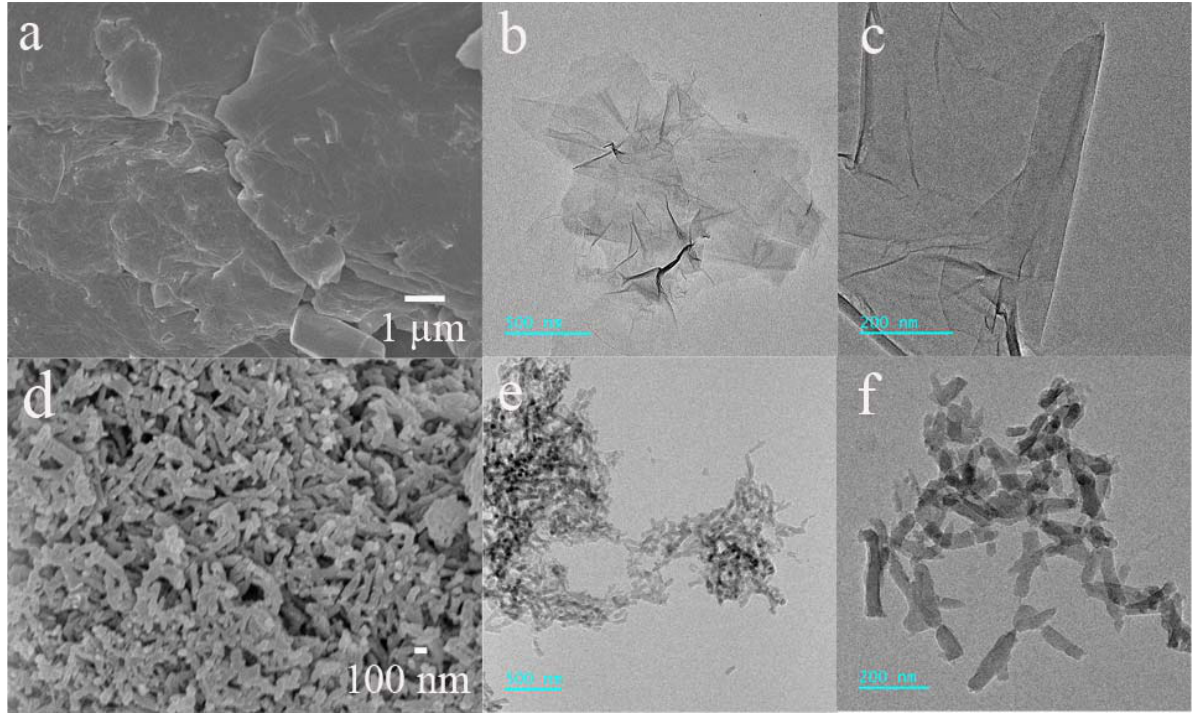
Figure 2. ( a ) SEM and ( b , c ) TEM images of GO, and ( d ) SEM and ( e , f ) TEM images of PANI.